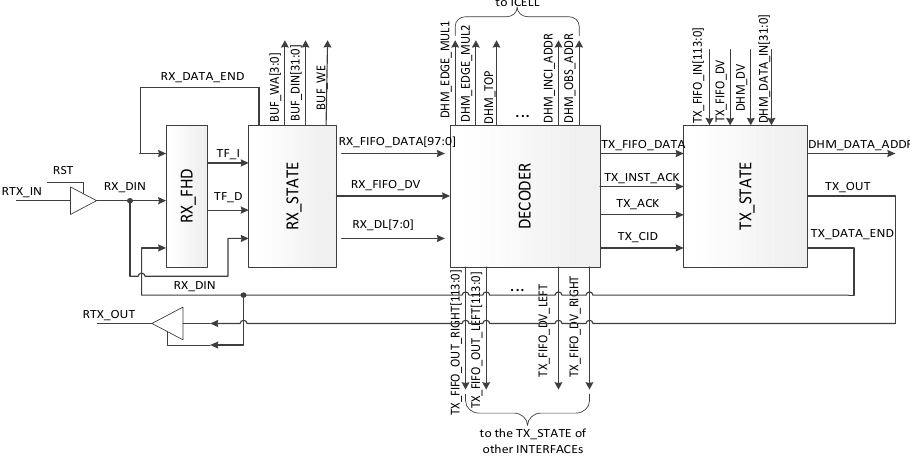
Figure 4. Diagram of the INTERFACE.